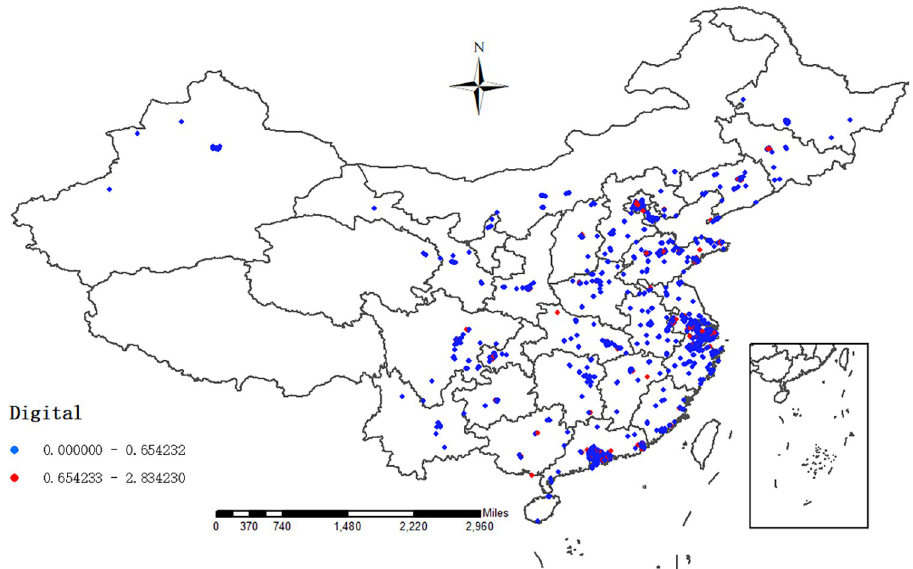
Fig 1. Distribution of digital transformation of listed companies (2018). Note: when the digital transformation of an enterprise is higher than the median value, it is an enterprise with high digital degree, which is represented by red dots in the map and others by blue